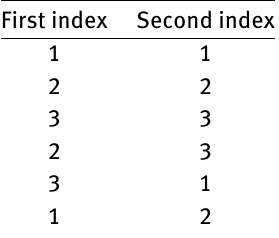
Table A1: Reconstruction table containing indices that relate fourth order tensors ( B and C ) in contracted notation to their expanded